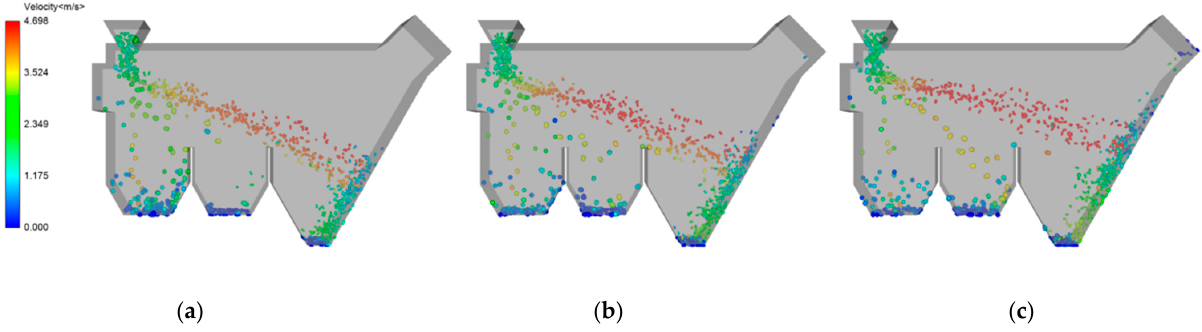
Figure 15. Airflow velocity contour plots of different inlet airflow velocity: ( a ) 7 m/s; ( b ) 8 m/s; ( c ) 9 m/s.